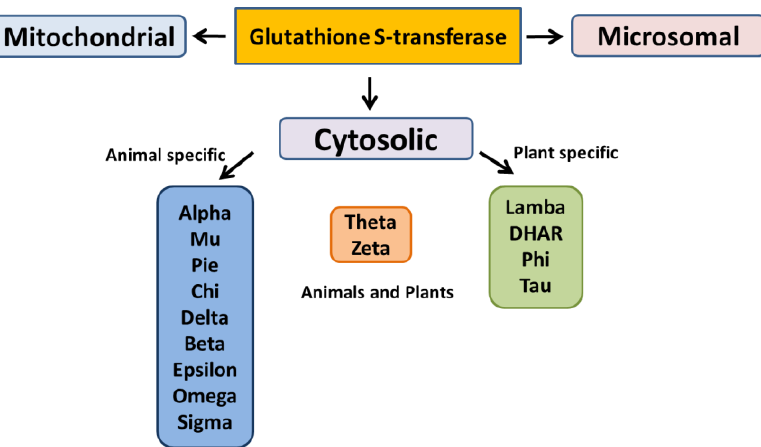
Figure 3. Different classes of glutathione S-transferase. The microsomal GSTs have been identified as the integral membrane proteins and are known as Membrane-Associated Proteins in Eicosanoid and Glutathione Metabolism (MAPEGs) while the mitochondrial GSTs are also referred as kappa-class GSTs [32]. GSTs are able to conjugate GSH to a wide range of endogenous electrophiles and xenobiotics. The endogenous 4-hydroxynonenal (4HNE) is an aldehyde resulting from lipid peroxidation that forms covalent adducts with DNA and proteins; high concentrations of 4HNE have been associated with apoptosis, altered gene expression,